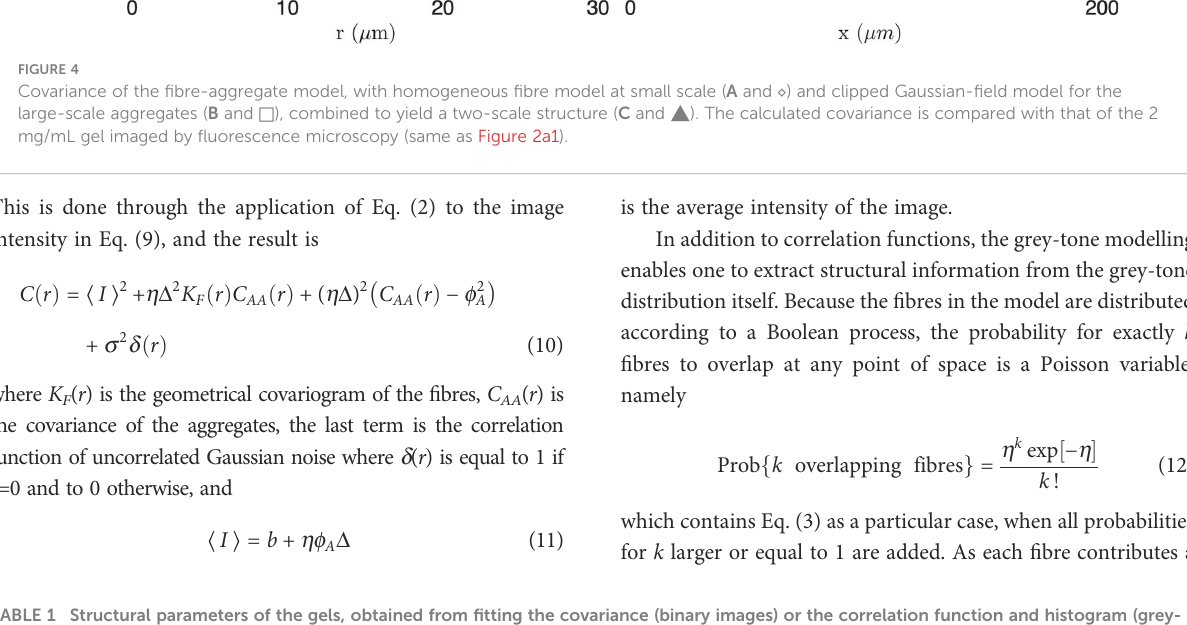
TABLE 1 Structural parameters of the gels, obtained from fi tting the covariance (binary images) or the correlation function and histogram (grey- tone images) with the fi bre-aggregate model. Imaging